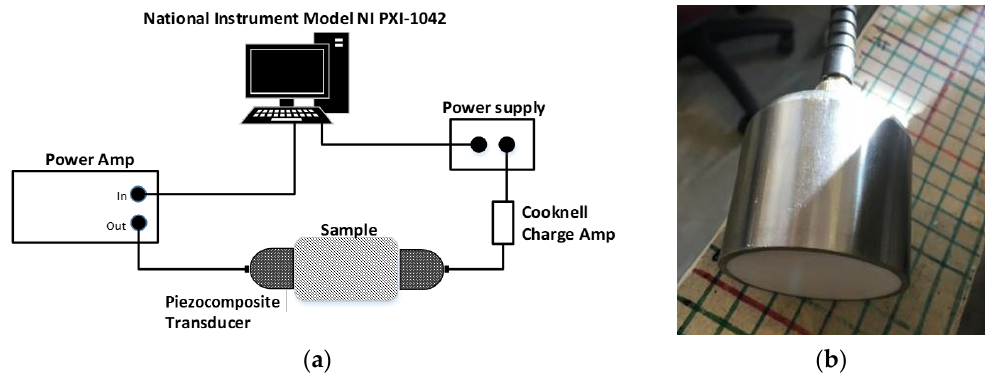
Figure 2. ( a ) Apparatus for low frequency ultrasound at a centre frequency of 150 kHz and a chirp signal swept from 100 – 200 kHz. ( b ) Piezo-composite transducer.